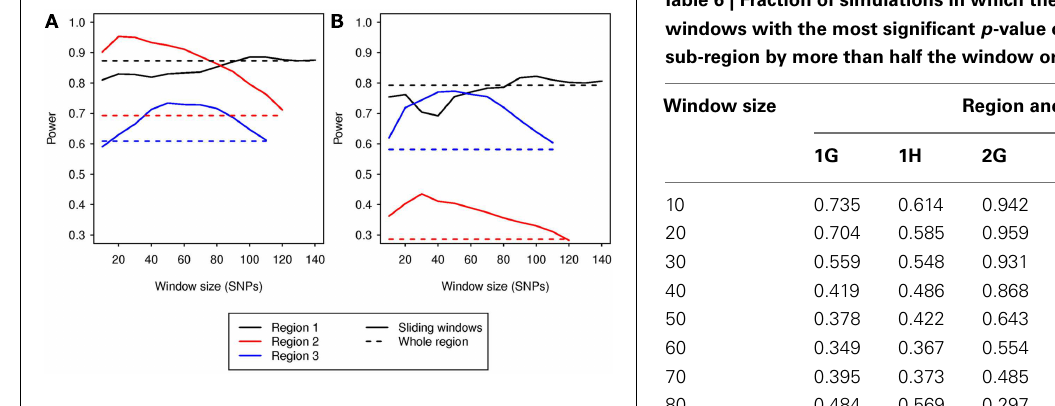
FIGURE 2 | Power vs. sliding window size. Solid lines depict power for each window size; dashed lines indicate power for analysis of the whole region, without sliding windows for (A) model G and (B) model H. Power is for a nominal α = 0.05.